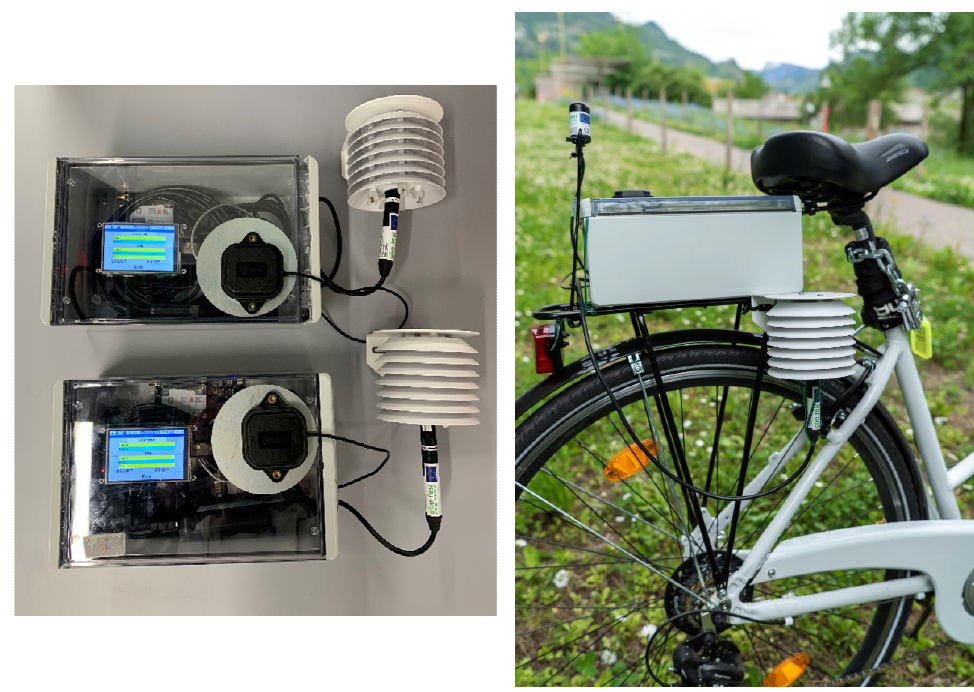
Figure 4. ( left ) Two completed prototypes housed in an IP-68 case. The touch screen interface, the GNSS double frequency antenna, and the T/RH sensor hosted in a solar radiation shield can be seen in the picture. ( right ) One prototype as it was installed on a Eurac Research bicycle. The pyranometers are mounted on the outermost support of the luggage carrier.